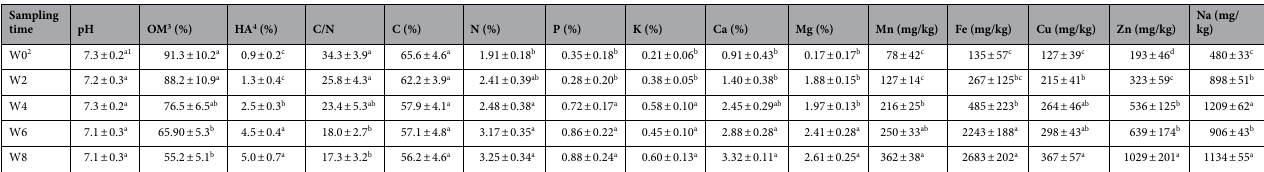
Table 2. The chemical properties of cattle manure at different sampling stage. 1 Different letters indicate significantly different results by LSD tests at p < 0.05. 2 0, 2, 4, 6, 8 week after compost. 3 Organic matter. 4 Humic acid.